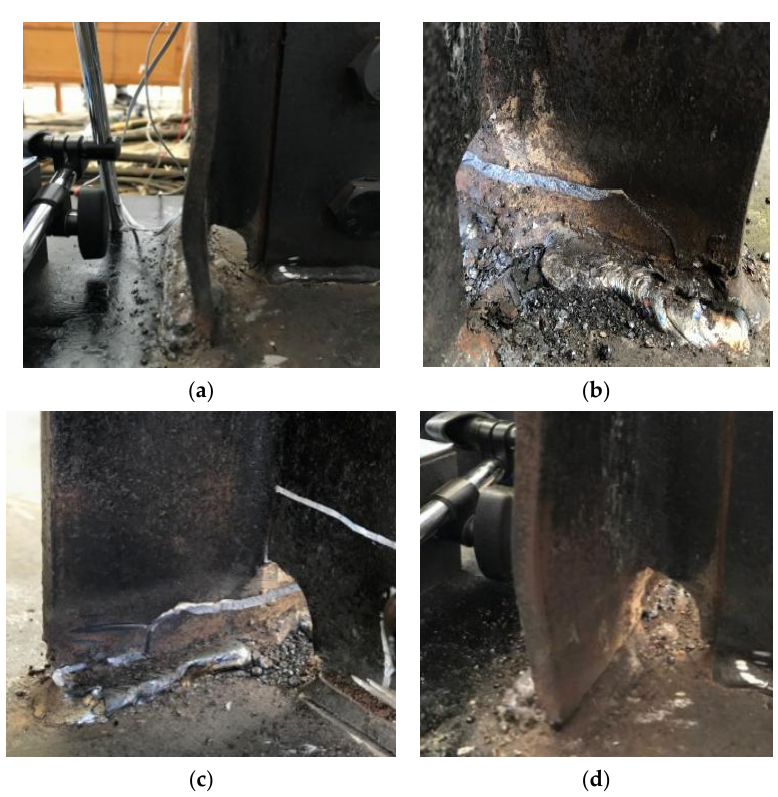
Figure 4. NBN specimen failure mode: ( a ) plastic hinge position; ( b ) A-side left flange destruction form; ( c ) A-side right flange destruction form; ( d ) B-side right flange destruction form.